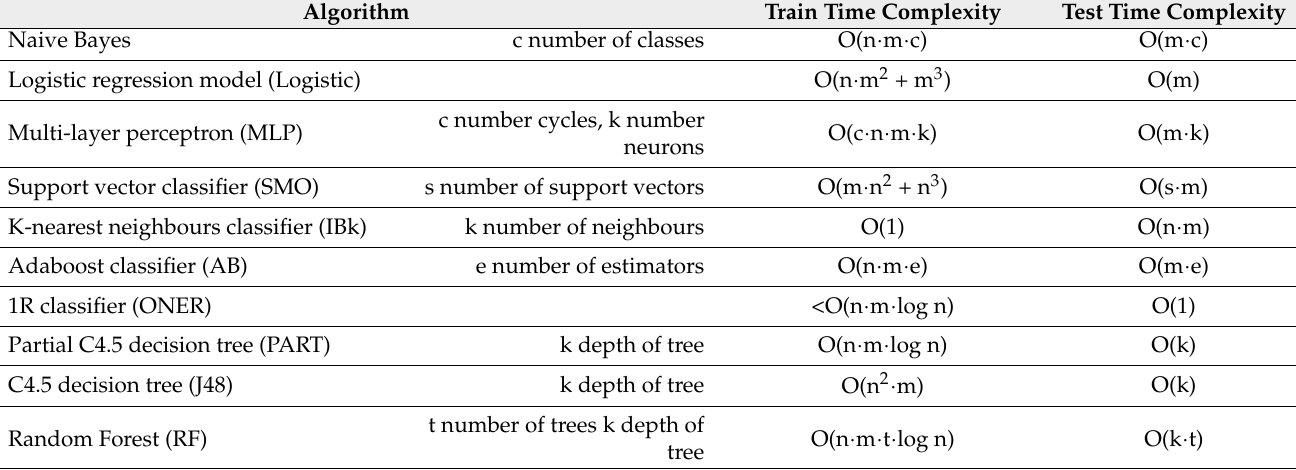
Table 3. Computational complexity for different ML techniques.